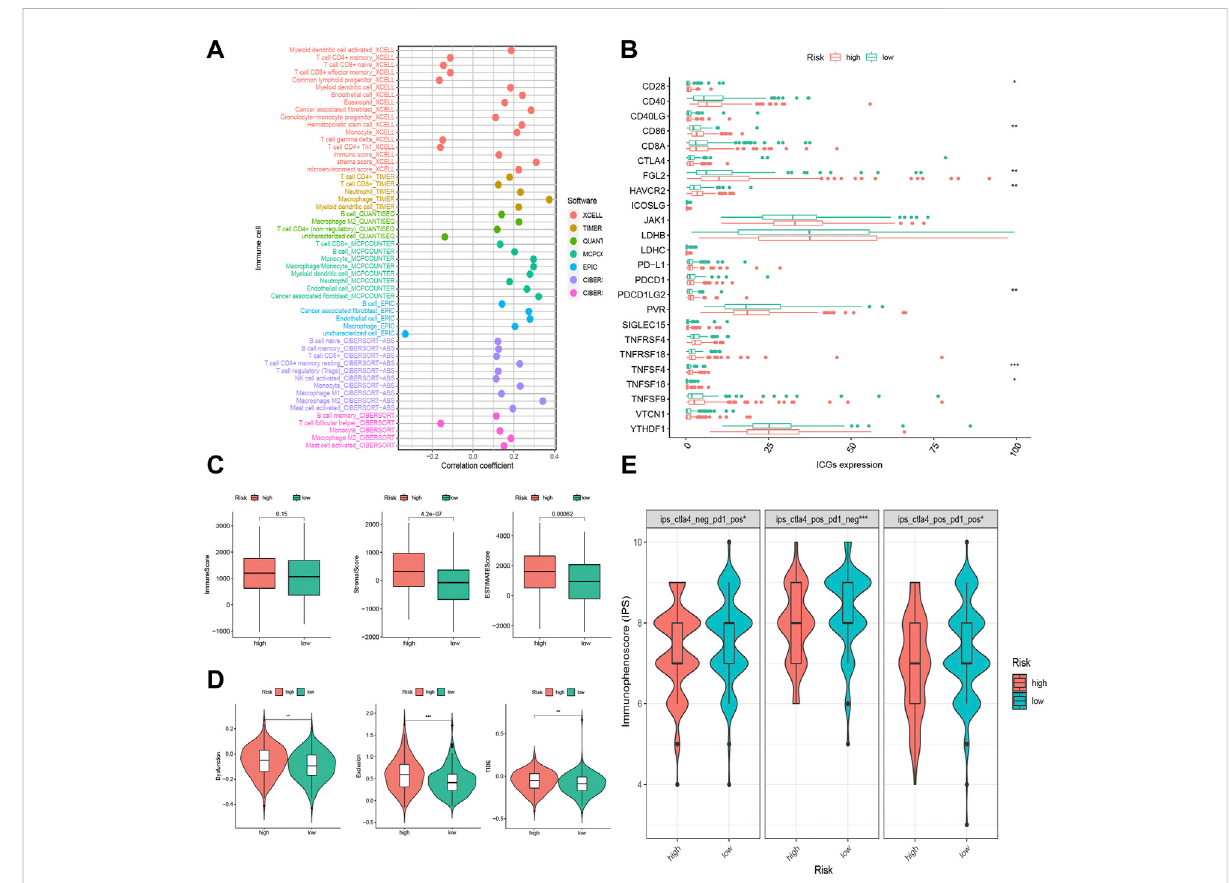
FIGURE 6 Tumorin fi ltratingimmunecells(TIICs)andImmunotherapeuticsensitivityanalysisoftheFRLPriskscoremodel. (A) Thecorrelationbetweenrisk score and TIICs analyzed by seven different quanti fi cation methods of immune in fi ltration estimations including TIMER, xCell, quanTIseq, MCP- counter,EPIC,CIBERSORT-ABS,andCIBERSORT. (B) Expressionof24immunecheckpointgenesinhigh-andlow-riskgroups. (C) Boxplotsshowing Immunescore,Stromalscore,andESTIMATEscoreinhigh-andlow-riskgroups. (D) BoxplotsshowingDysfunctionscore,Exclusionscore,and tumor immune dysfunction and exclusion (TIDE) score differences between high- and low-risk score groups. (E) Immunophenoscore (IPS) differences for ICB treatment between high- and low-risk groups; ips_ctla4_neg_pd1_pos refers to CTLA4-negative response and PD1-positive response;ips_ctla4_pos_pd1_neg referstoCTLA4-positiveresponseandPD1-negativeresponse;ips_ctla4_pos_pd1_pos referstoCTLA4-positive response and PD1-positive response (* p < 0.05, ** p < 0.01, *** p <